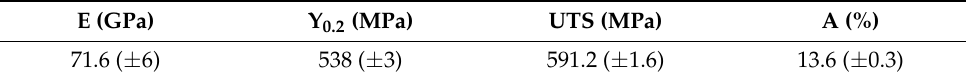
Table 2. AA7075-T6 mechanical properties in the as-delivered